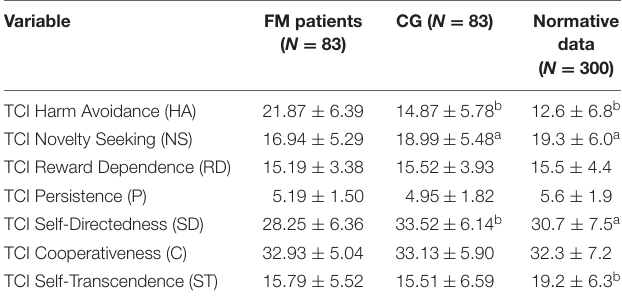
TABLE 1 | FM patients’ personality characteristics: comparisons with control group (CG) and normative